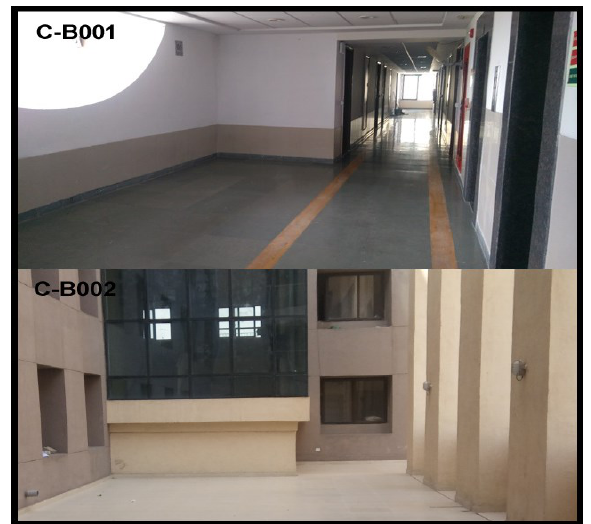
Figure 7. CCTV for Fire Detection at RGIPT